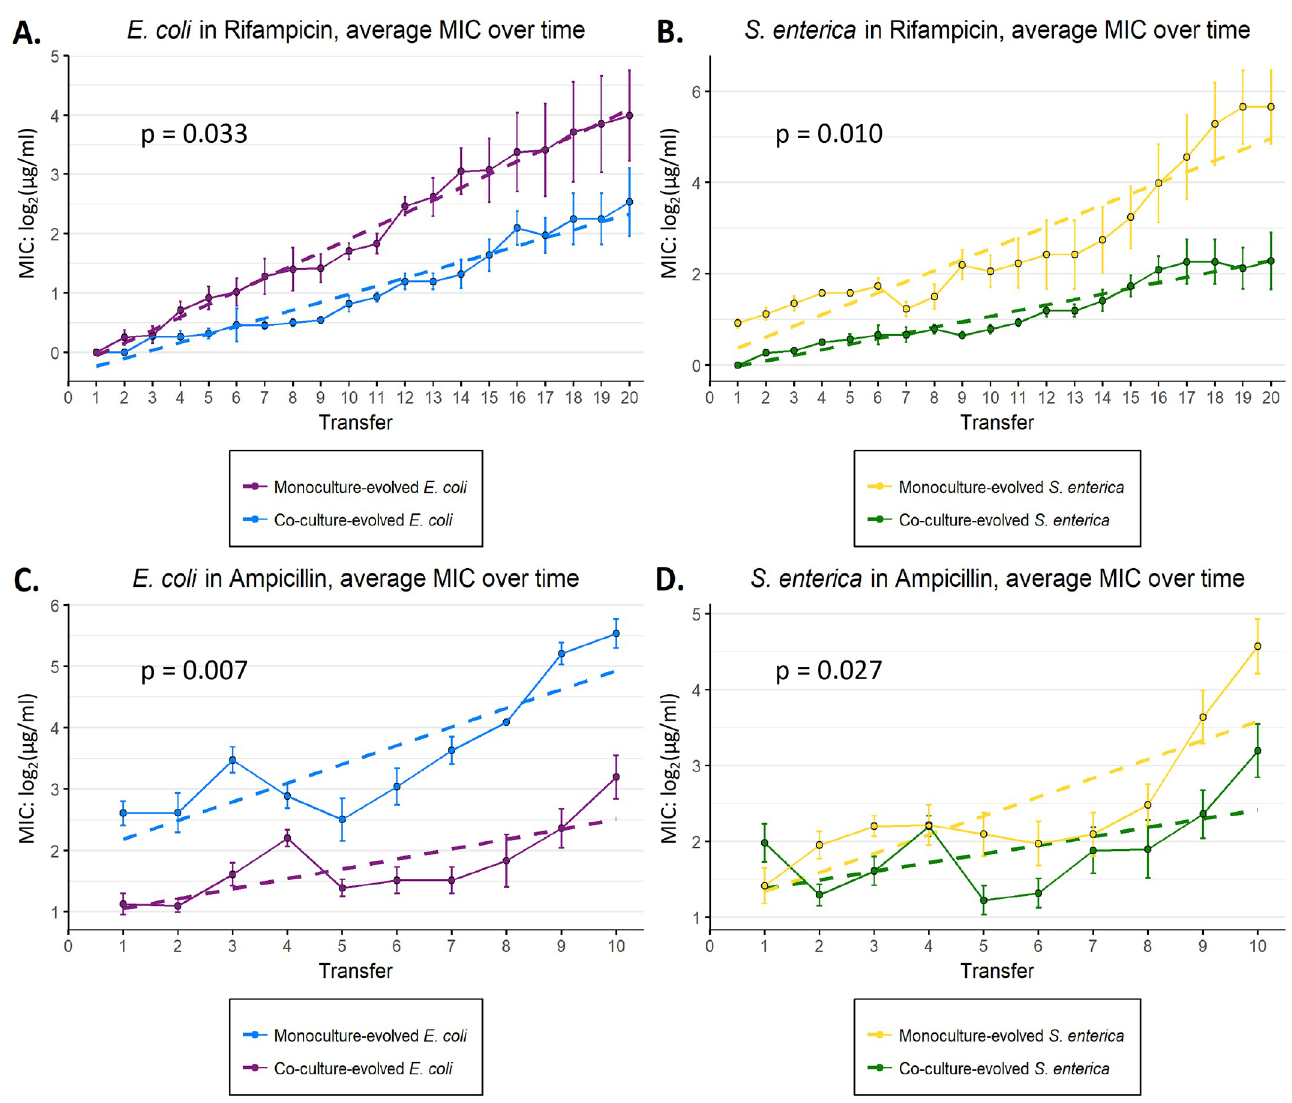
Fig 2. Resistance evolves more slowly in co-culture-evolved populations vs. monoculture-evolved populations. Six replicate populations each of monocultures and co-cultures were evolved along a rifampicin gradient ( A-B ) or an ampicillin gradient ( C-D ); gradients were identical for monocultures and co-cultures. Population MICs for each species ( E . coli A, C ; S . enterica B, D ) were measured each transfer and the resulting MICs plotted. Statistical analysis was performed using a mixed-effects model with a randomized slope for each replicate within a culture type. The fitted slopes for each treatment are indicated by the dashed lines. P-values are for the interaction term between passage and culture type. Error bars represent the standard deviation of MIC among the six replicates.